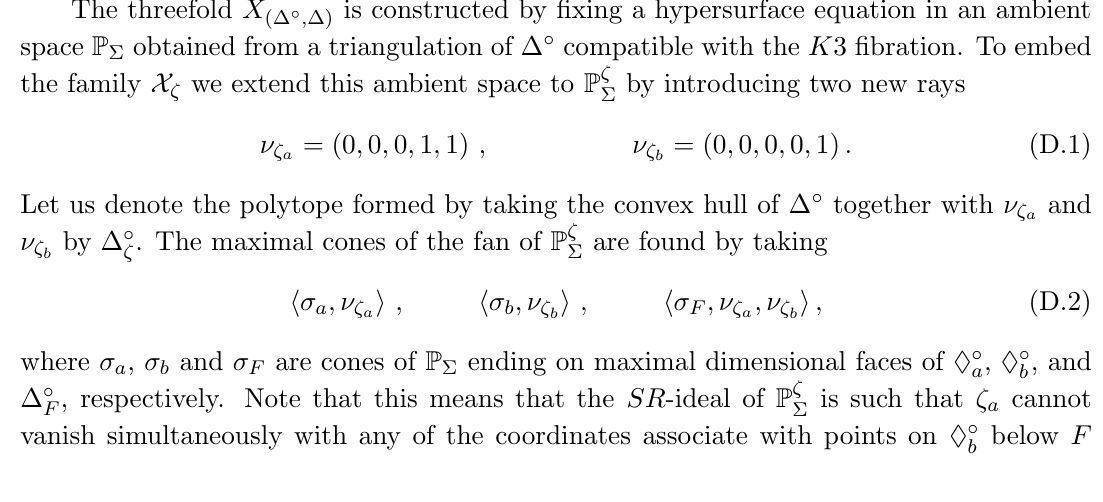
t , the singular ((cid:1) ; (cid:1) (cid:14) ) and Z ( (cid:6) a ; (cid:6) (cid:14) a ) ( (cid:6) b ; (cid:6) (cid:14) ) b